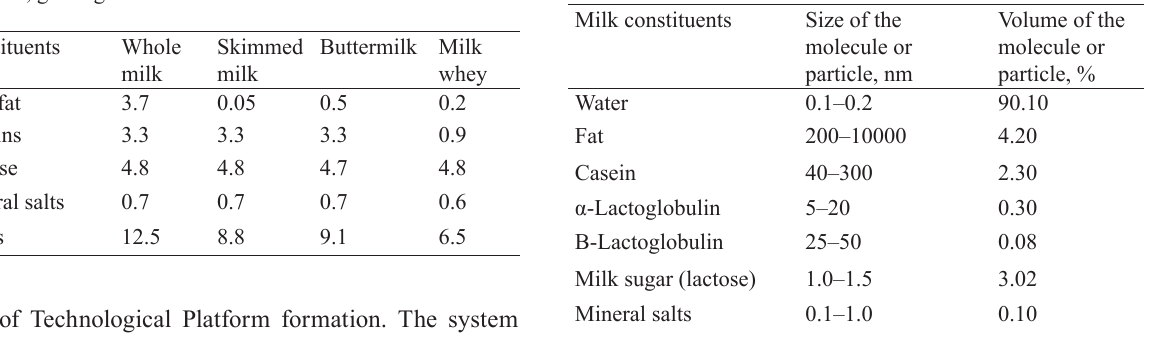
Table 3 Dispersed composition of dairy